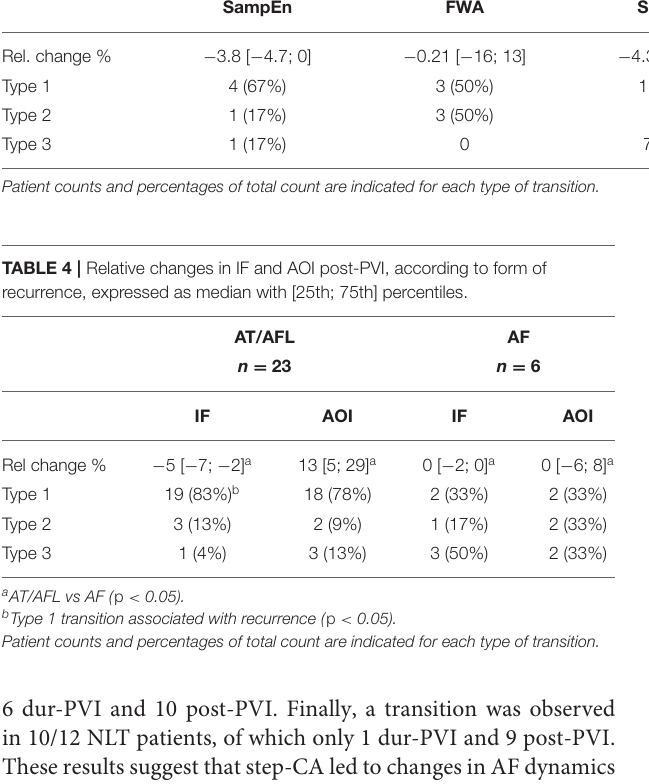
TABLE 3 | Relative changes in SampEn and FWA post-PVI, according to ablation outcomes, expressed as median with [25th; 75th] percentiles. LTN LTR NLT n = 6 n = 18 n = 11 SampEn FWA SampEn FWA SampEn FWA Rel. change % 0